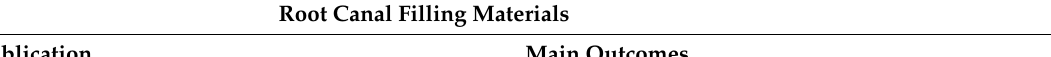
Table 1. Main outcomes reviewed, grouped in chronological order by material